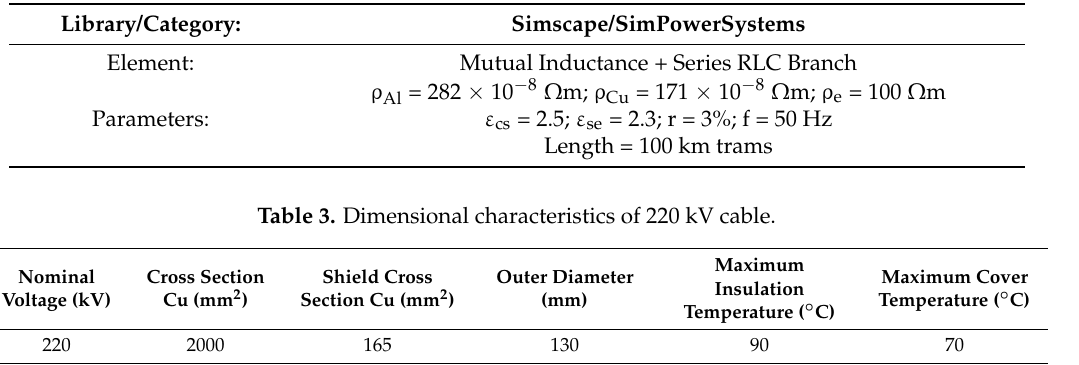
Figure 9. Model for analysis of the circulations of ground fault currents in shields of power cables.